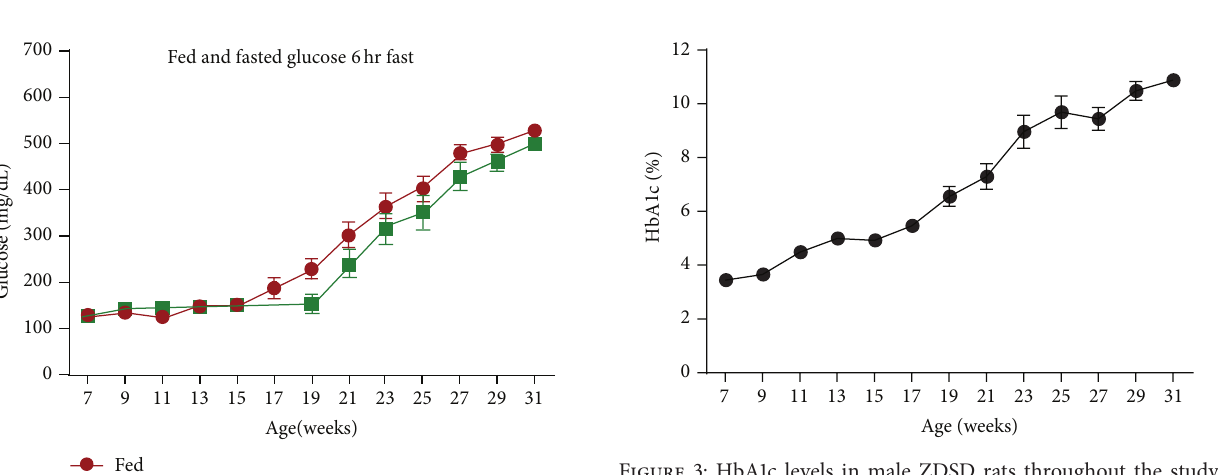
Figure 3: HbA1c levels in male ZDSD rats throughout the study duration of rats in ages from 7 to 31 weeks (mean ± SEM, 𝑛 = 23 ). weeks during the experiment. For clarity purposes, only data at eight-week intervals are presented (Figure 4(a)). Signifi- cant abnormalities in glucose disposal were observed in aging ZDSD rats during performance of oral glucose tolerance